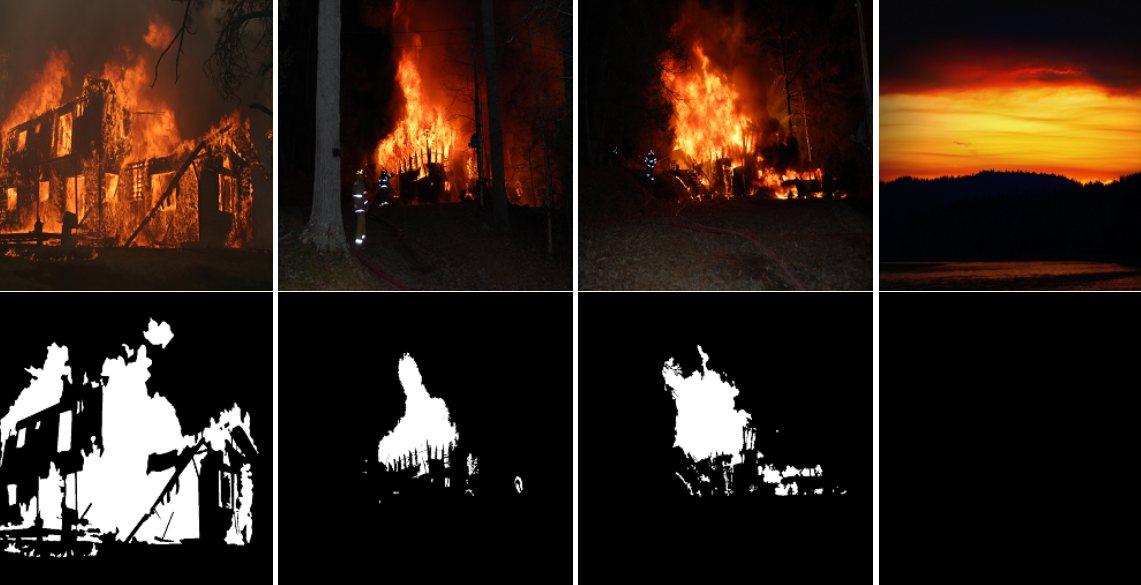
Figure 5. Samples of the BowFire dataset. ( Top ): RGB images; ( Bottom ): their corresponding binary